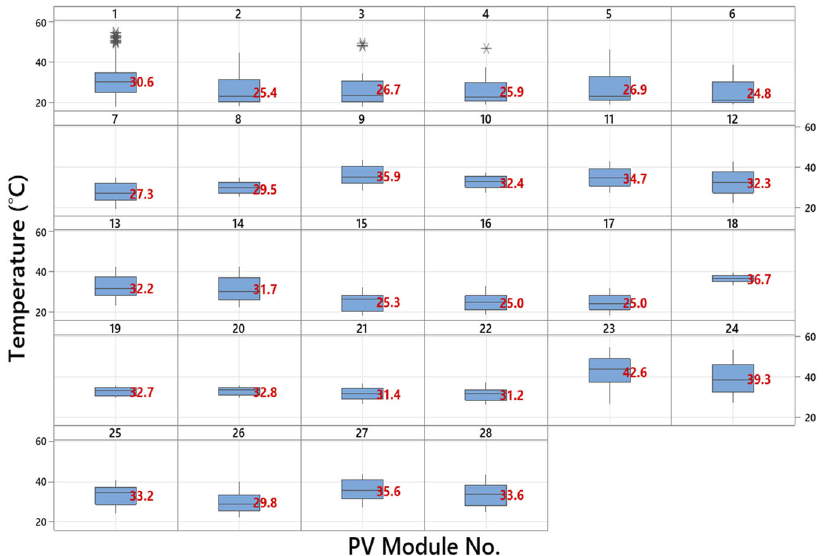
Fig. 8 Extracted PV modules temperature after PID test was performed. The error bars represent the collected data of the 28 tested PV modules after completing a single PID test (96